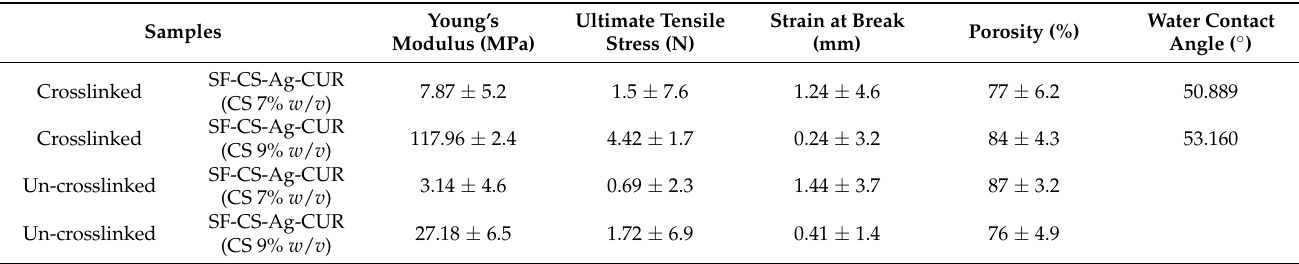
Table 3. Mechanical and physical characteristics of prepared electrospun nanofibers.